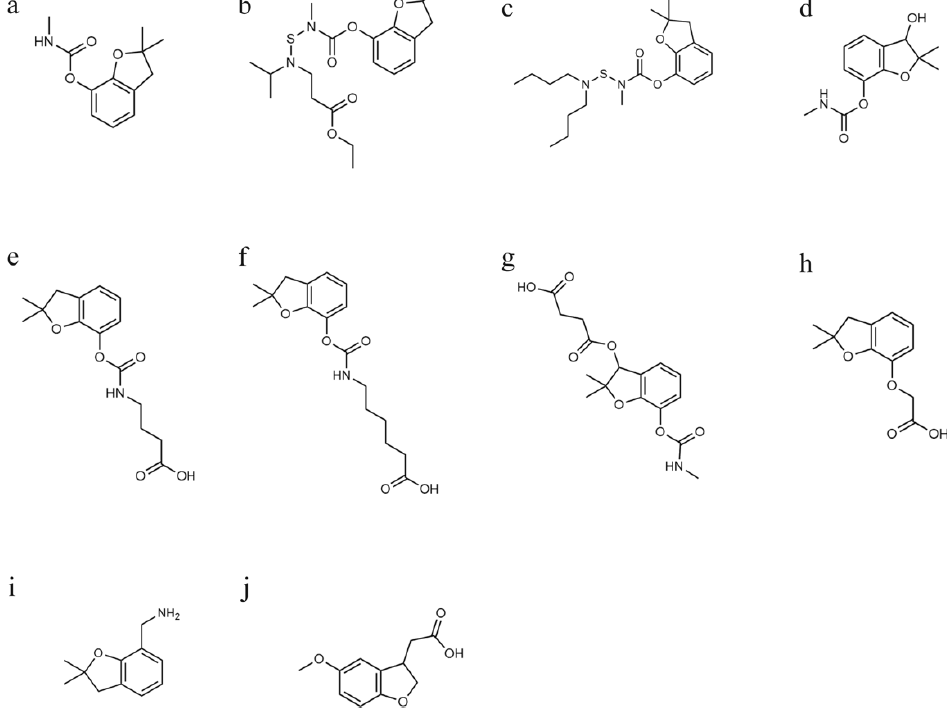
Figure 1. Chemical structures of carbofuran and its analogues. ( a ) Carbofuran. ( b ) Benfuracarb. ( c ) Carbosulfan. ( d ) 3-Hydroxy-Carbofuran. ( e ) BFNB. ( f ) BFNH. ( g ) 3-Succinyl-Carbofuran. ( h ) BFOA. ( i ) DDB. ( j ) MDA.